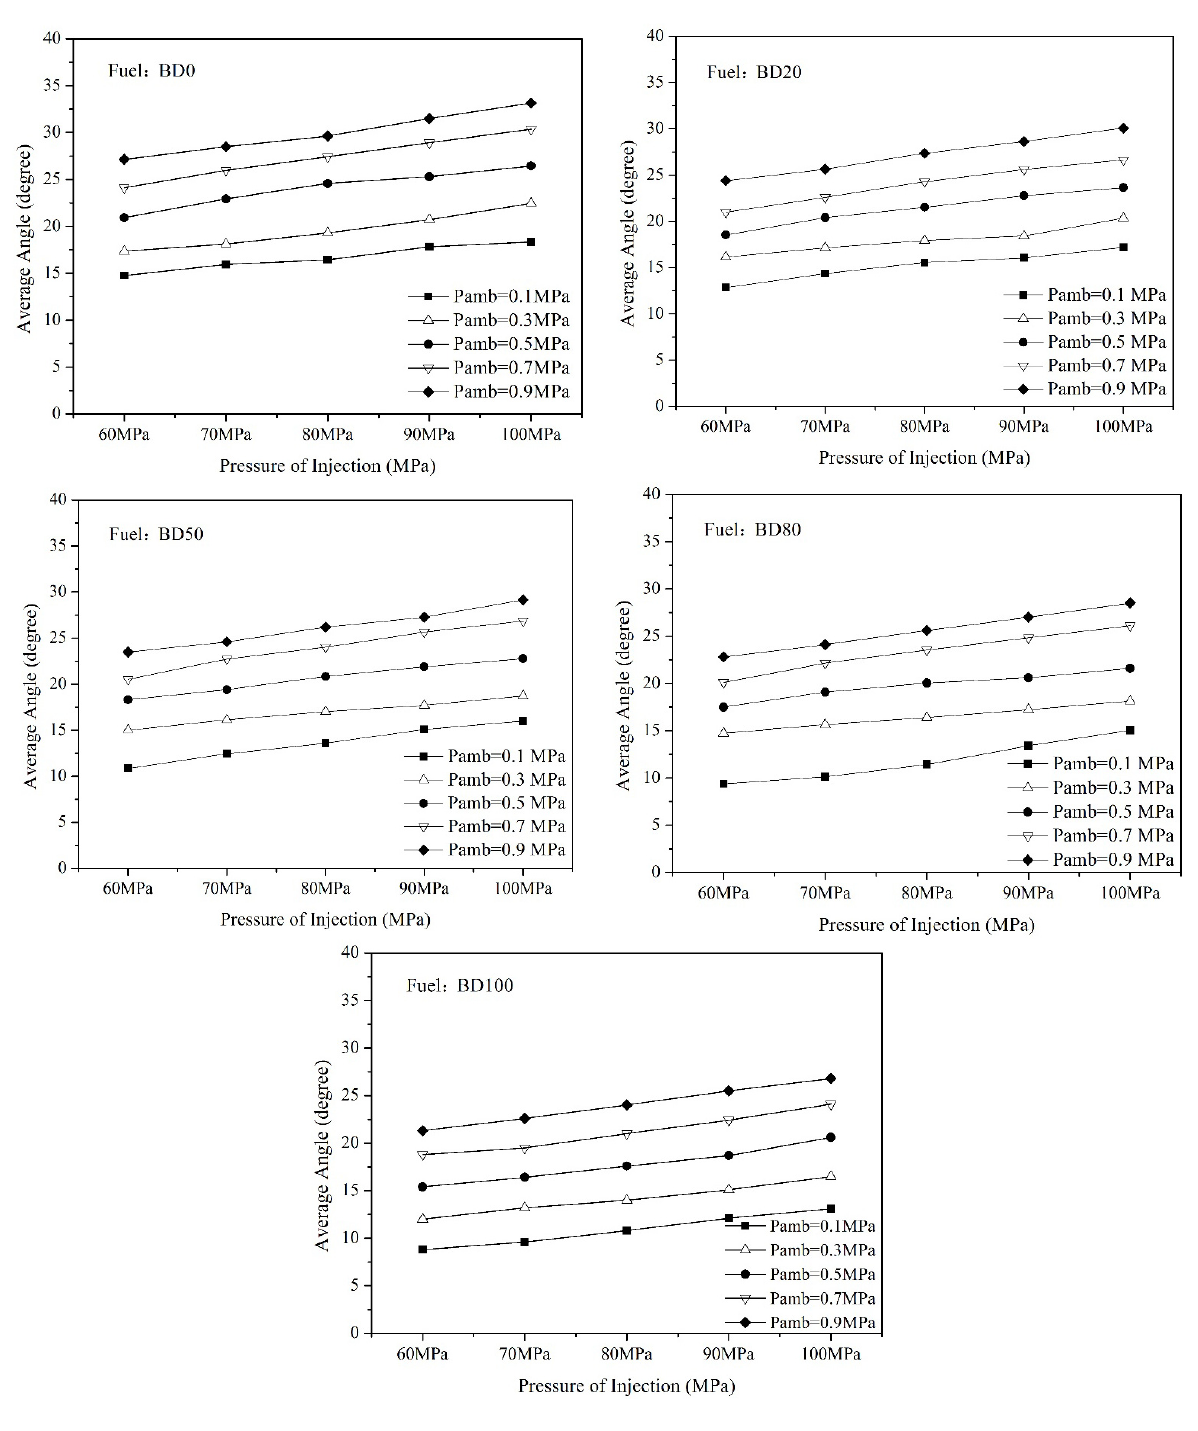
Figure 6. The average angle for all